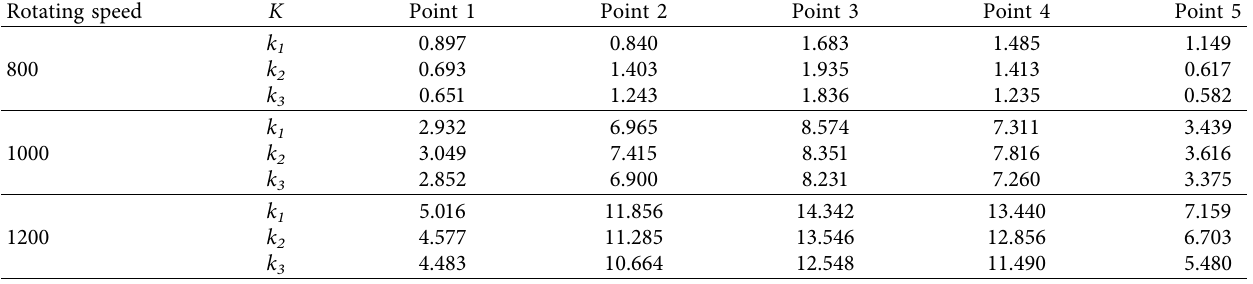
Table 2: Vibration response amplitude of composite beams with different support